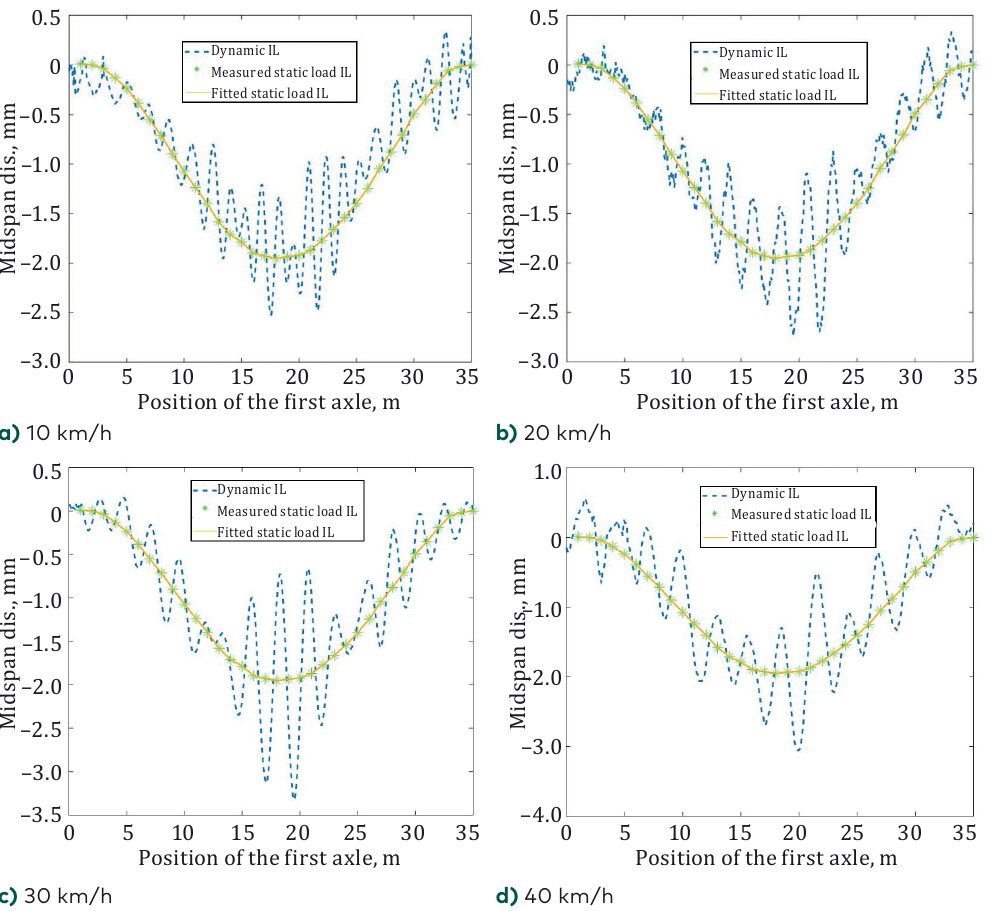
Figure 3. Raw data in the 2nd span of 4 loading